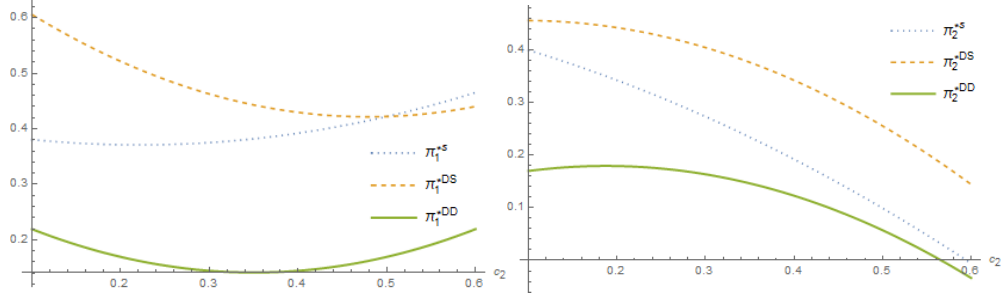
Figure 4. The impacts of re-broadcasting rights cost on profits in three cases.